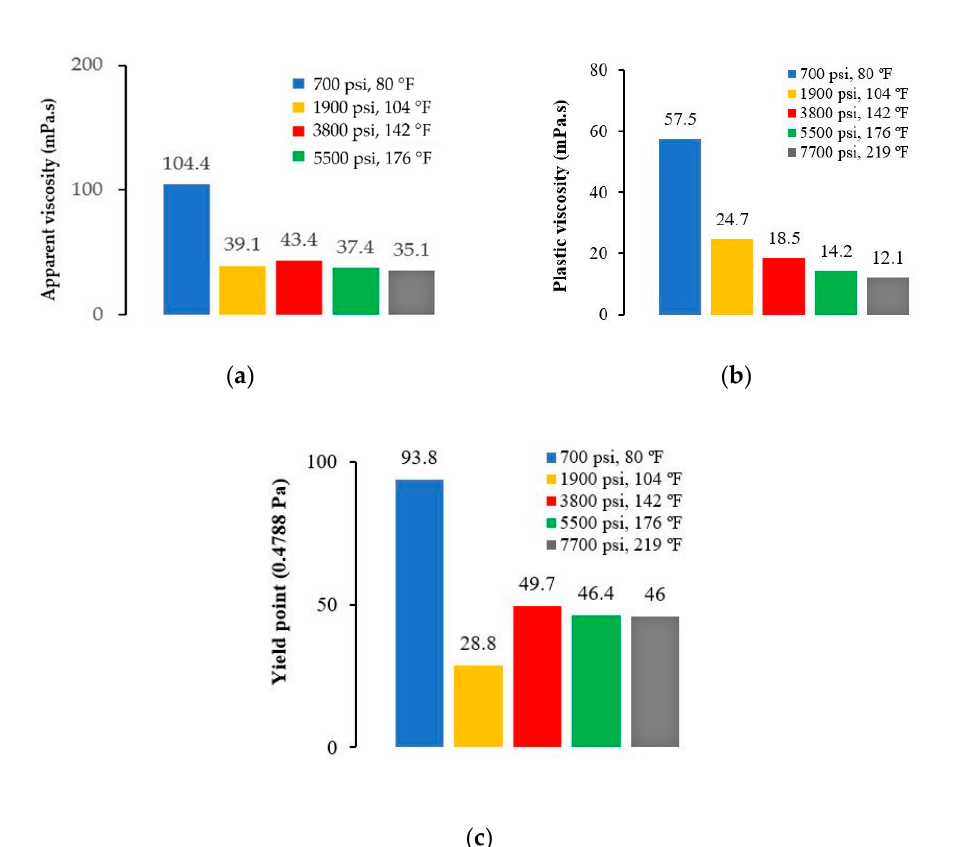
Figure 7. Rheological properties of EDF at HPHT conditions as ( a ) apparent viscosity; ( b ) plastic viscosity; ( c ) yield point.